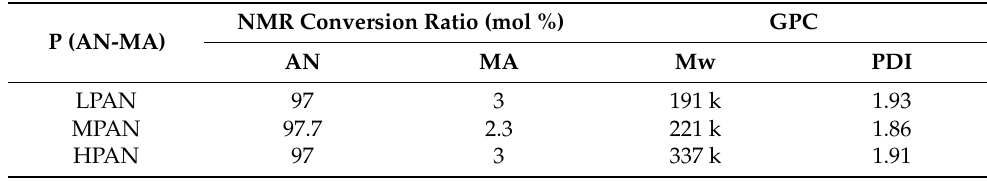
Table 1. 1 H NMR and GPC analysis of P (AN-MA) copolymers. P